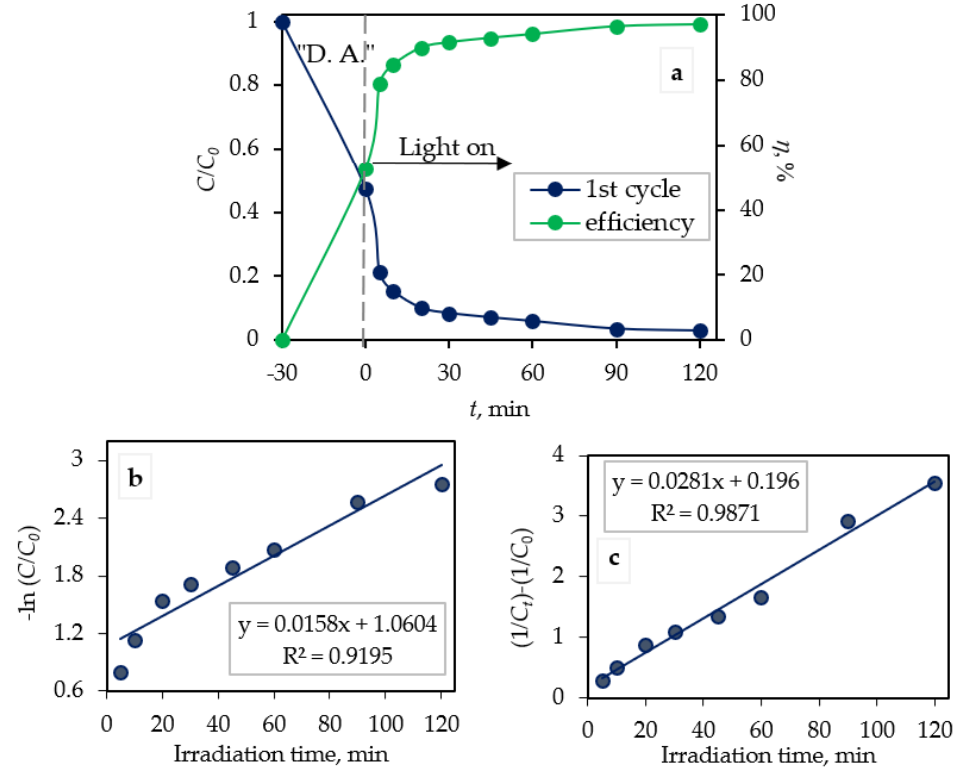
Figure 9. ( a ) Photocatalytic degradation of CIP by the Fe 3 O 4 /SiO 2 /TiO 2 nanocomposite synthesized at 100 °C monitored via UV/VIS spectrophotometry. The pseudo-first-order plot ( b ) and the pseudo- second-order plot ( c ) of CIP photocatalytic degradation.